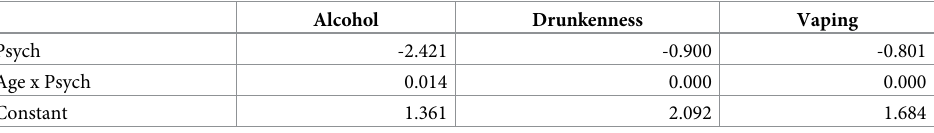
Table 2. B weights used for estimating the probability of use for three